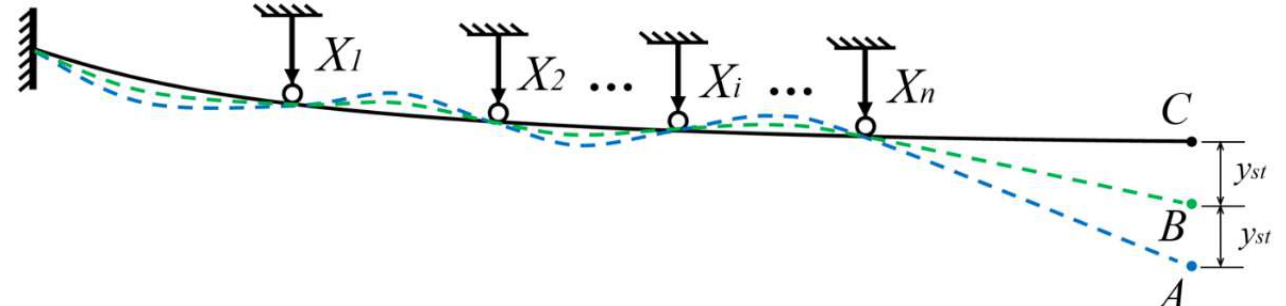
Figure 6. Scheme of the process of pipeline oscillations with a sudden removal of the static load